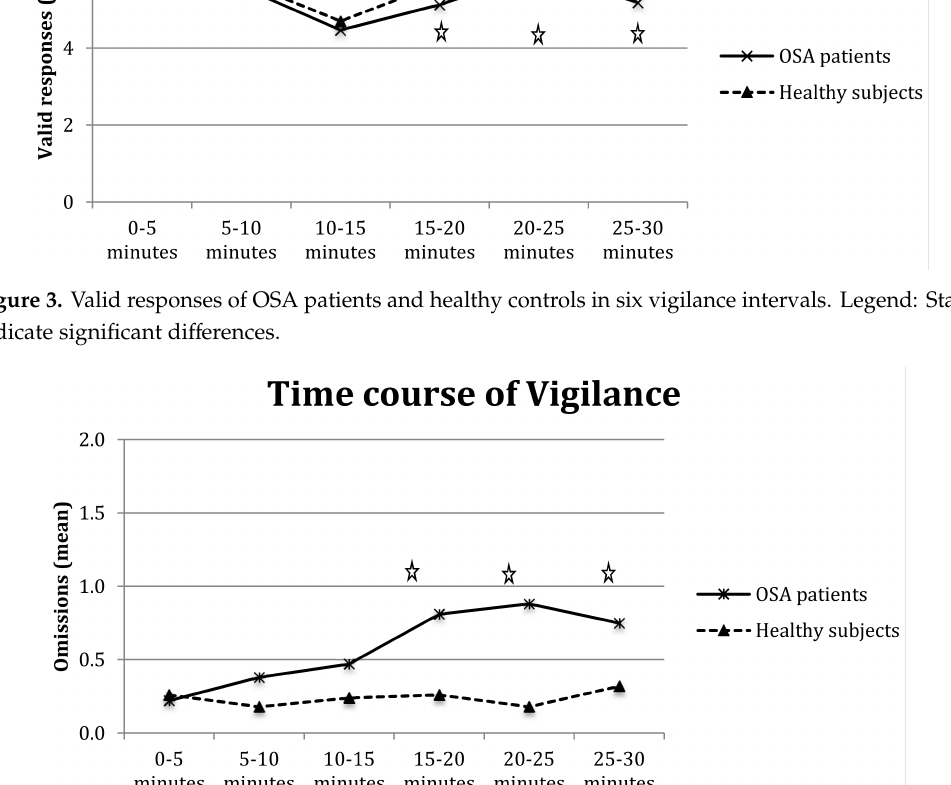
Figure 4. Omissions of OSA patients and healthy controls in six vigilance intervals. Legend: Stars indicate significant di ff